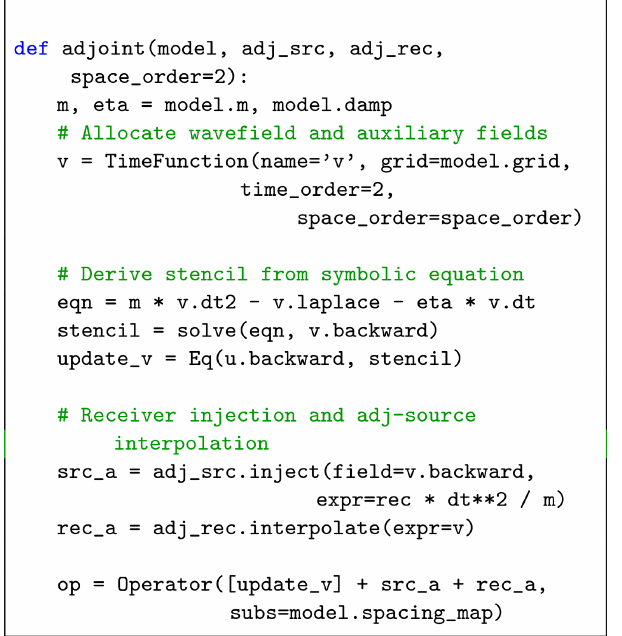
Figure 6. Example definition of a gradient